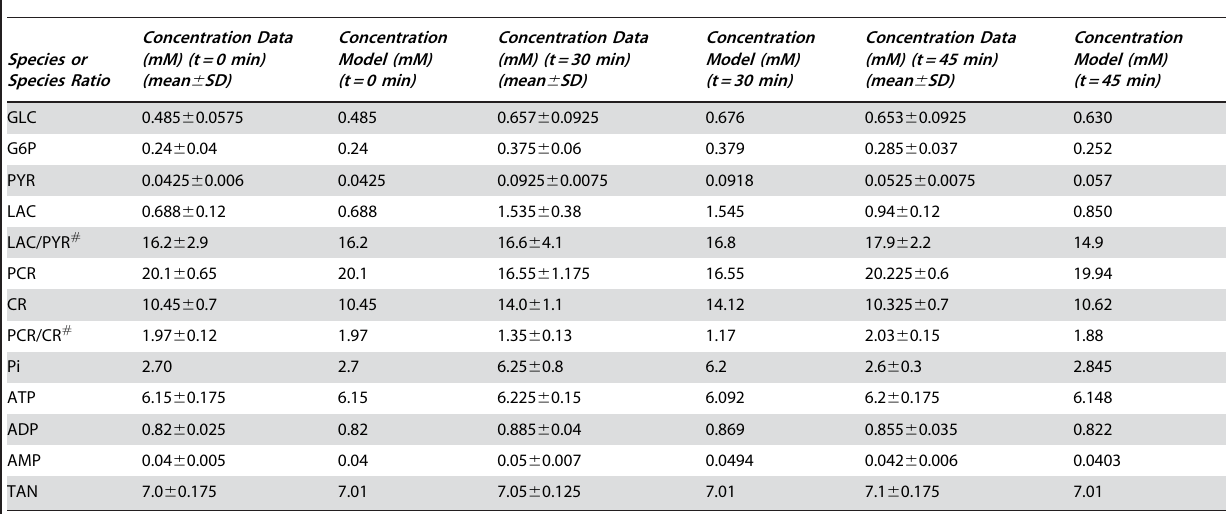
Table 5. Model simulation results compared with the experimental data of Katz [22] on muscle ischemia.*